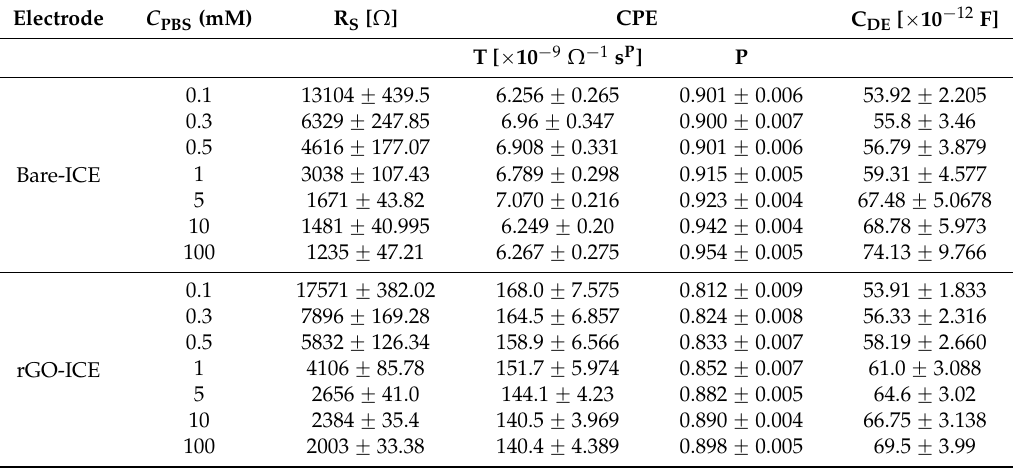
Figure 3. Impedance magnitude of ( a ) bare ICE; ( b ) rGO-ICE and phase of ( c ) bare ICE; ( d ) rGO-ICE measured with respect to the concentration of phosphate-buffered saline (PBS) (Data), and lines fitted using the equivalent circuit model (Fit) consisting of the solution resistance (R s ), the constant phase element for the electrode interfacial impedance (CPE) and the dielectric capacitance of the solution (C DE ). Table 1. Extrapolated values of the equivalent circuit elements from the fitting results in Figure 3.